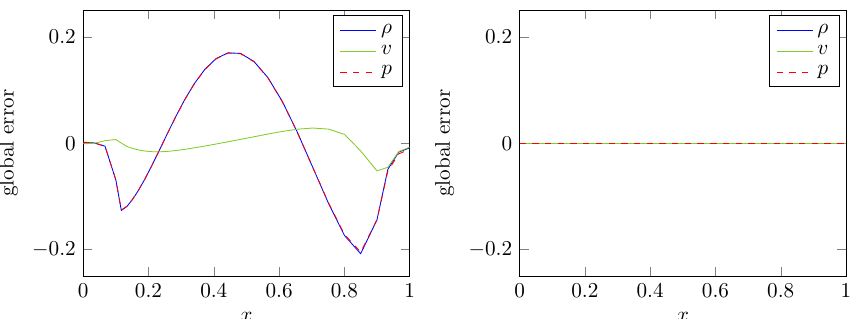
Figure 4. Global error with respect to density, velocity and pressure at time T = 0.035 for explicit Euler scheme with step size h = 10 − 3 applied to constant flow. Left : Use of exact grid velocities; Right : Computation of grid velocities consistent with the geometric conservation law (GCL).